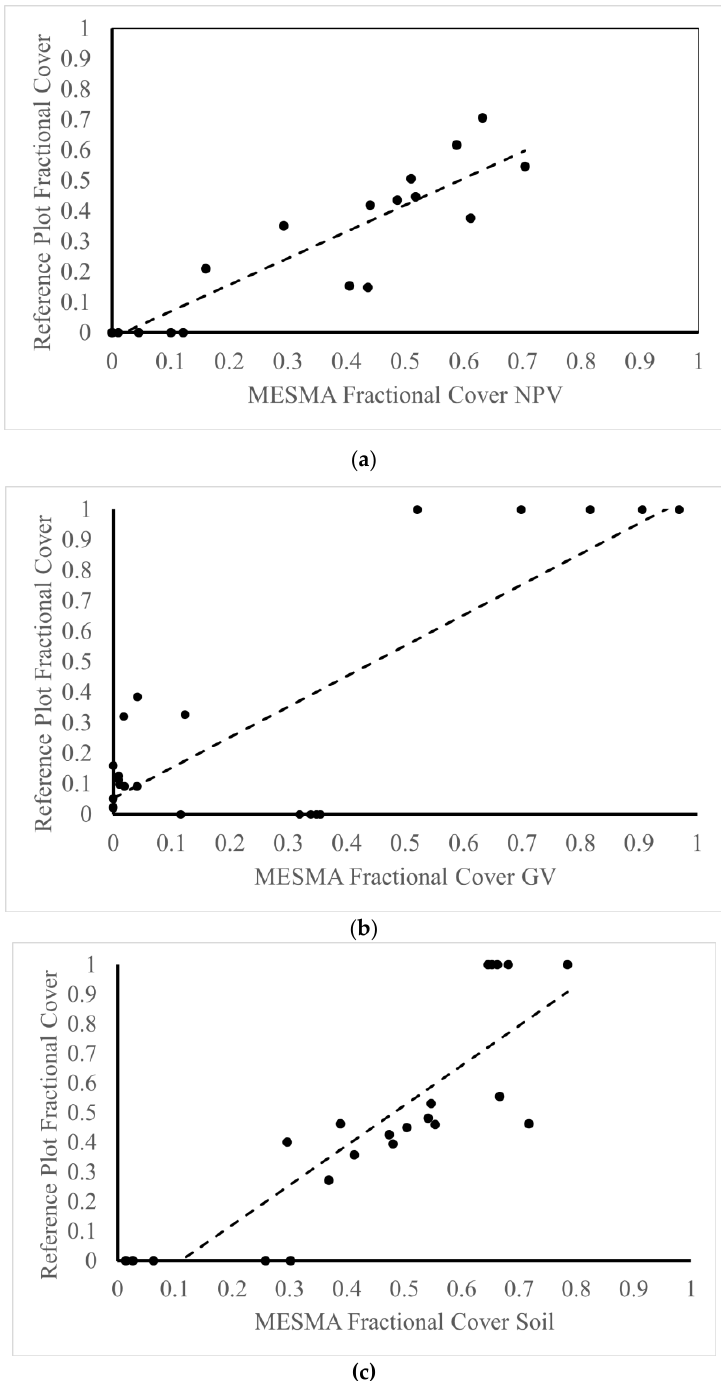
Figure 4. Accuracy assessment results of the best fit MESMA fraction image: ( a ) NPV R 2 = 0.8474; ( b ) GV R 2 = 0.6696; ( c ) Soil R 2 = 0.7401.